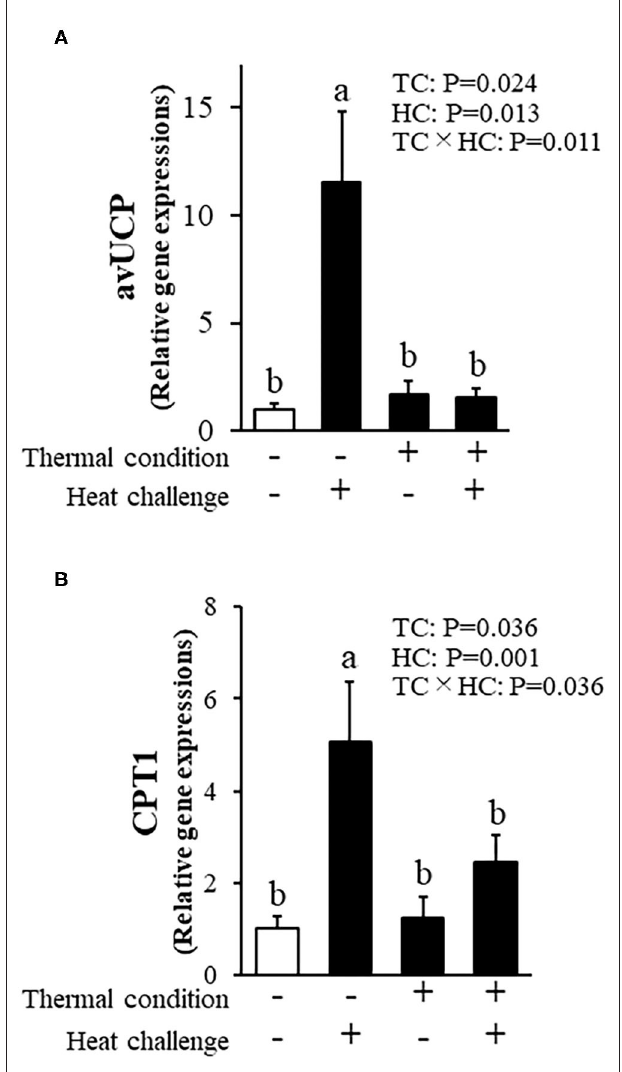
FIGURE 7 | Effect of thermal conditioning on gene expression in the pectoral muscle of chicks. (A) Avian uncoupling protein (av-UCP), (B) carnitine palmitoyltransferase-1 (CPT1). TC, thermal condition; HC, heat challenge. Data were expressed as means ± SEM. Means with different letters are significantly different at P < 0.05. The number of chickens in each group was n = 7–8. + : treatment, –: non-treatment. There is a significant difference between different